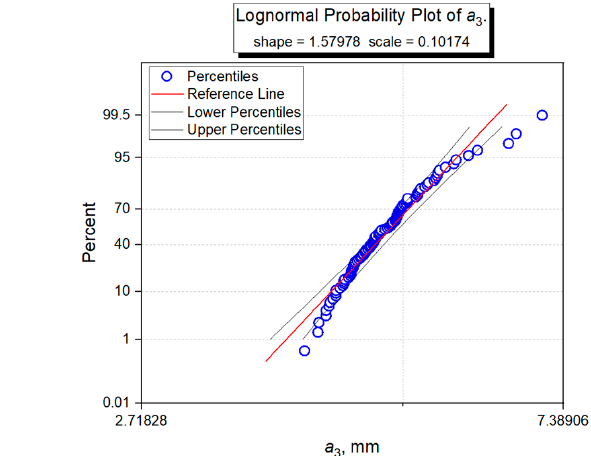
Table 4. Results of the distribution of goodness-of-fit tests.